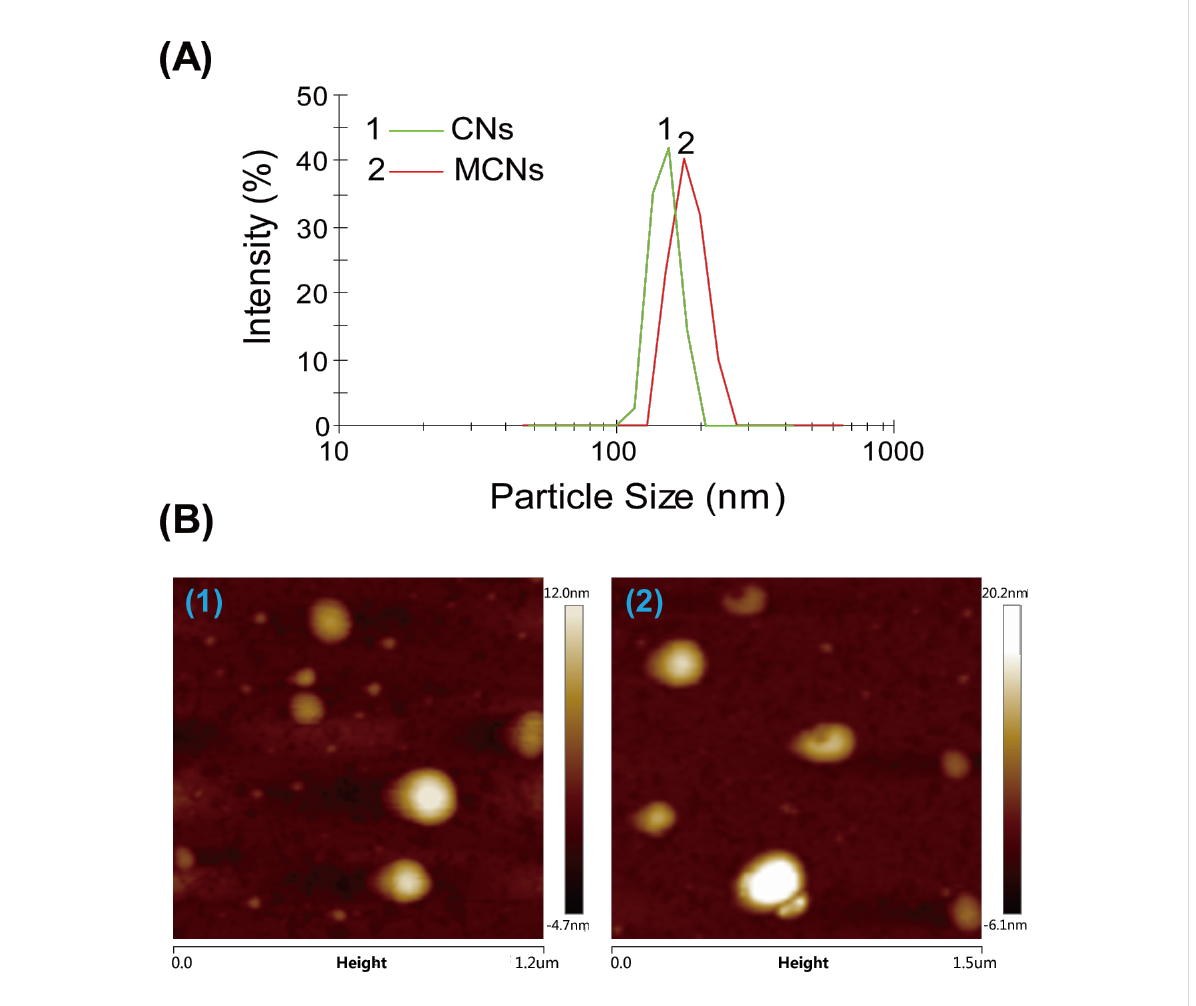
Figure 5: (A) DLS measurements of (1) CNs and (2) MCNs. (B) AFM images of (1) CNs and (2)